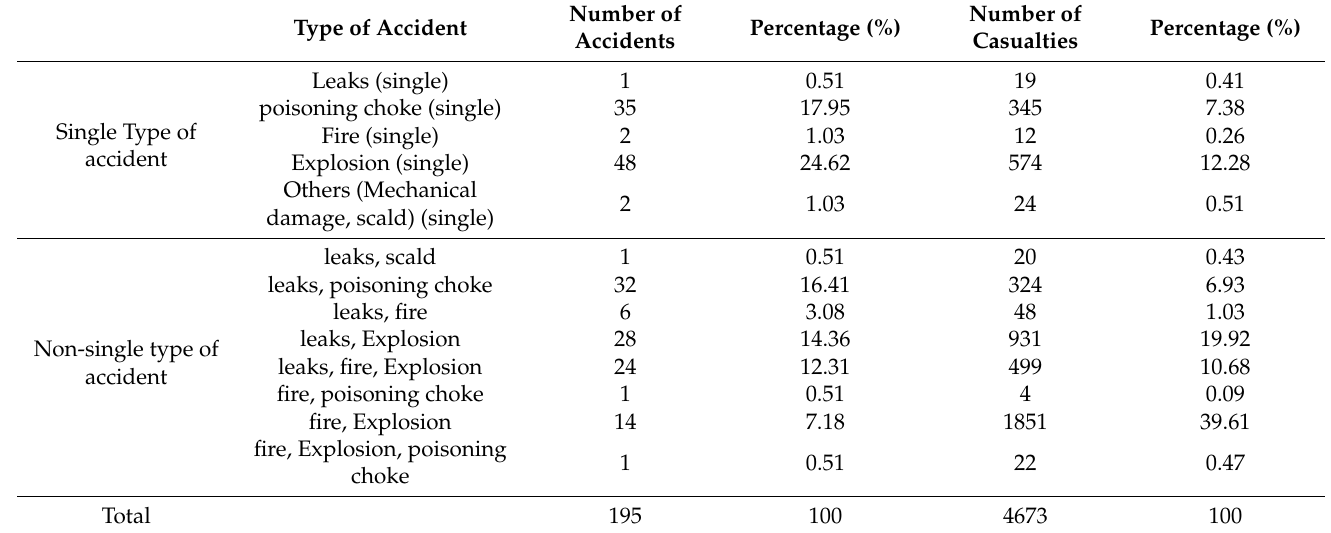
Table 3. Statistics on types and Casualties of large and above chemical accidents from 2000 to